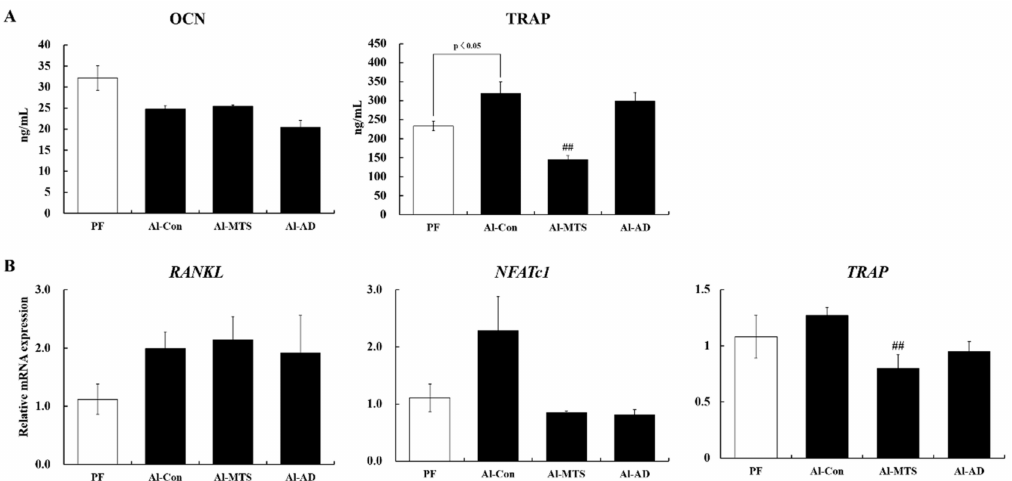
Figure 2. E ff ect of methoxsalen supplementation on serum osteocalcin (OCN) and tibial tartrate-resistant acid phosphatase 5 (TRAP) ( A ) and tibia osteoclast-related gene expression ( B ) in chronic alcohol-fed rats. The values are expressed as the mean ± S.E. ## p < 0.01 vs. Al-Con according to a Student’s t -test. RANKL : receptor activator of nuclear factor kappa-B ligand and NFATc1 : nuclear factor of activated T-cells, cytoplasmic 1. Table 1. E ff ects of methoxsalen supplementation on serum parameters in chronic alcohol-fed rats. PF Al-Con Al-MTS Al-AD Ca (U / L) 10.01 ± 0.25 9.35 ± 0.14 * 9.71 ± 0.17 9.35 ± 0.24 IP (U / L) 8.14 ± 0.26 8.17 ± 0.26 7.80 ± 0.35 7.12 ± 0.45 Alcohol (mg / L) 33.75 ± 7.18 55.40 ± 5.09 * 30.27 ± 3.66 ## 28.12 ± 5.92 ## Acetaldehyde (mg / L) 41.85 ± 11.62 66.57 ± 19.37 28.22 ± 5.03 22.90 ± 3.45 AST (U / L) 94.20 ± 9.34 374.80 ± 93.30 * 194.80 ± 24.63 319.83 ± 68.09 ALT (U / L) 30.00 ± 5.06 274.80 ± 87.44 * 86.60 ± 15.14 116.40 ± 18.14 TNF- α (pg / mL) 208.67 ± 23.43 299.62 ± 19.86 * 131.45 ± 34.99 ## 237.33 ± 9.74 # IL-6 (pg / mL) 4.33 ± 0.16 3.92 ± 0.17 3.56 ± 0.21 3.40 ±